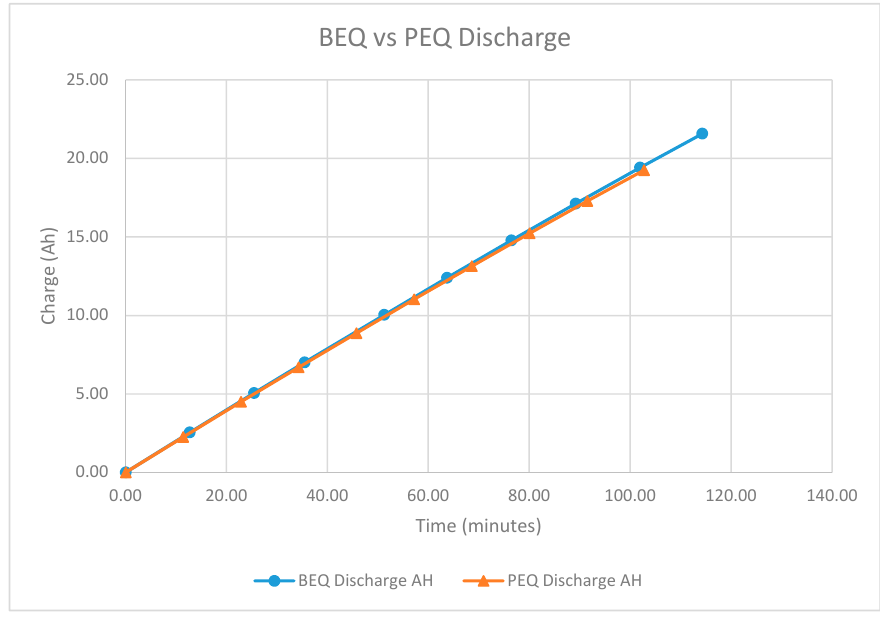
Figure 9. Discharging Ah vs. Time for the BEQ and PEQ with 24 GAIA